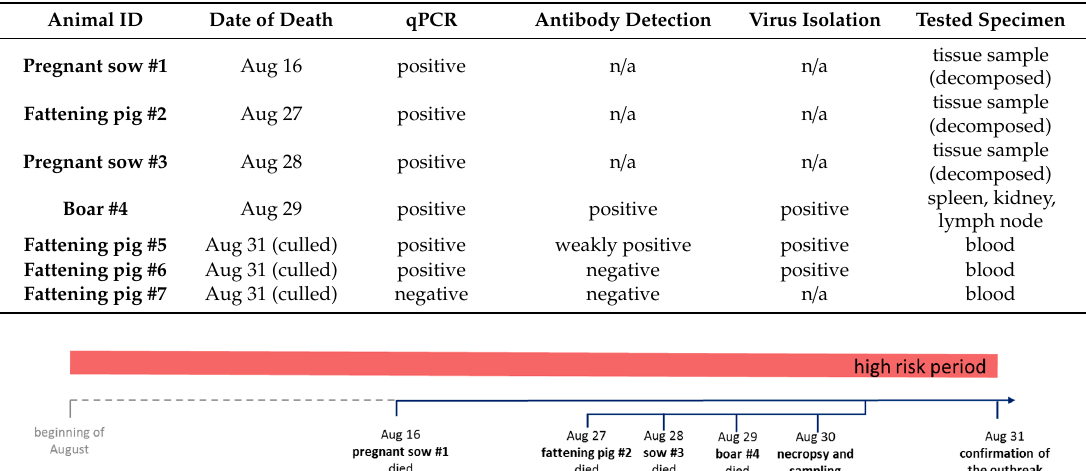
Table 1. Overview of pigs in the a ff ected farm including test results.